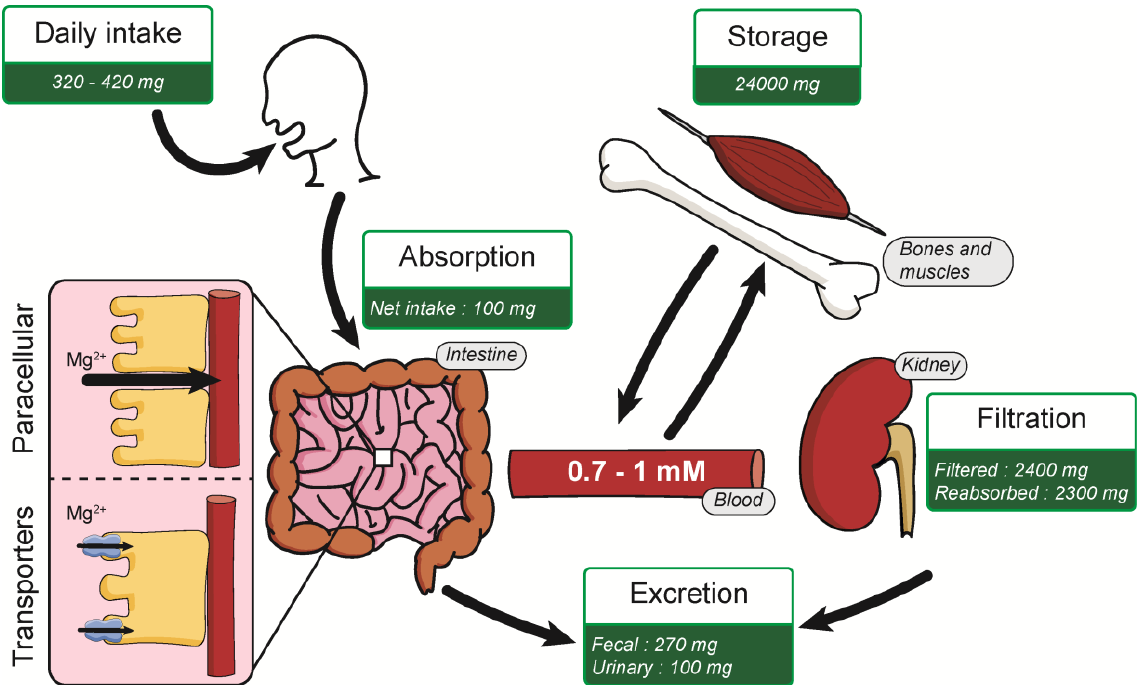
Figure 1. Summary of Mg 2+ homeostasis.